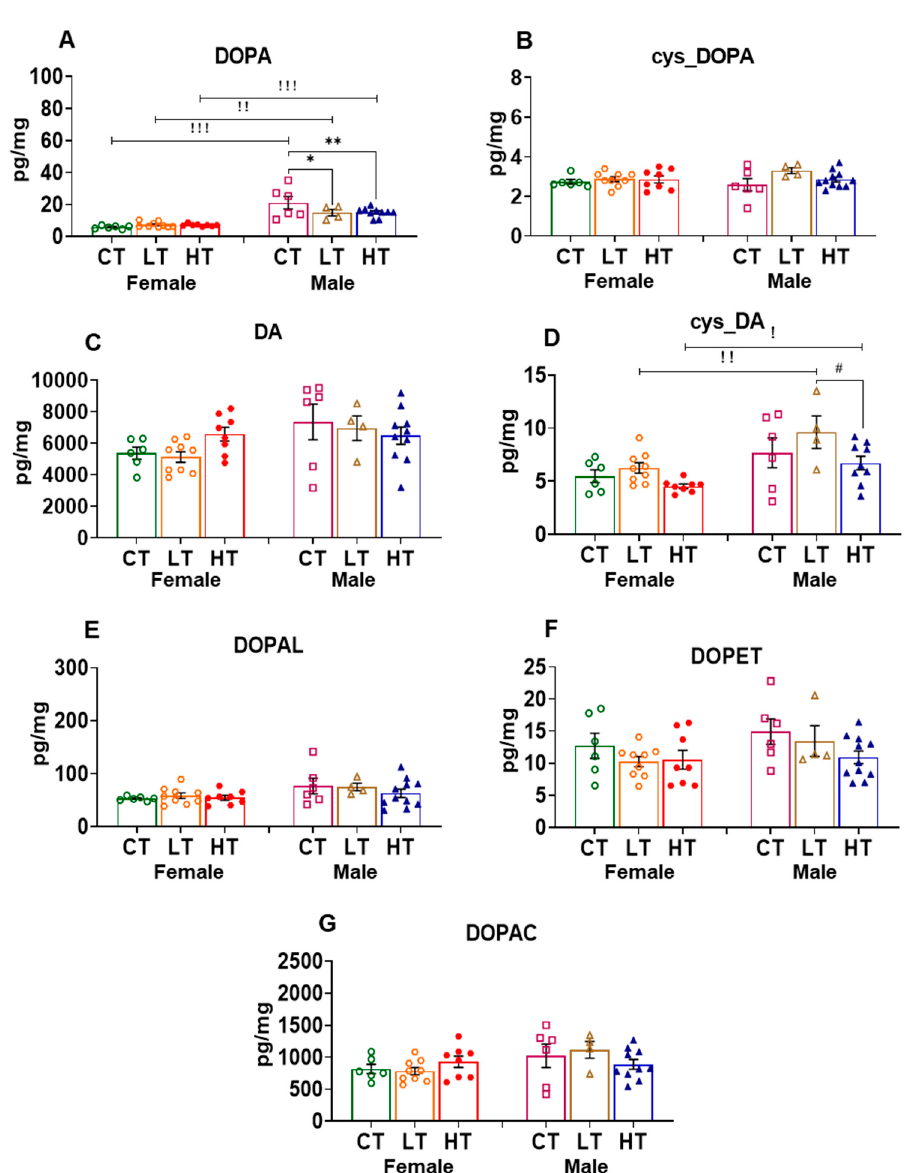
Figure 4. Effect of METH SA and withdrawal in the dorsal striatum (dSTR) dopamine and its metabolites level. ( A ) DOPA, ( B ) cys_DOPA, ( C ) DA, ( D ) cys_DA, ( E ) DOPAL, ( F ) DOPET, and ( G ) DOPAC in female and male rats. * p < 0.05, ** p < 0.01. # p < 0.05. ! p < 0.05,!! p < 0.01,!!! p < 0.001.